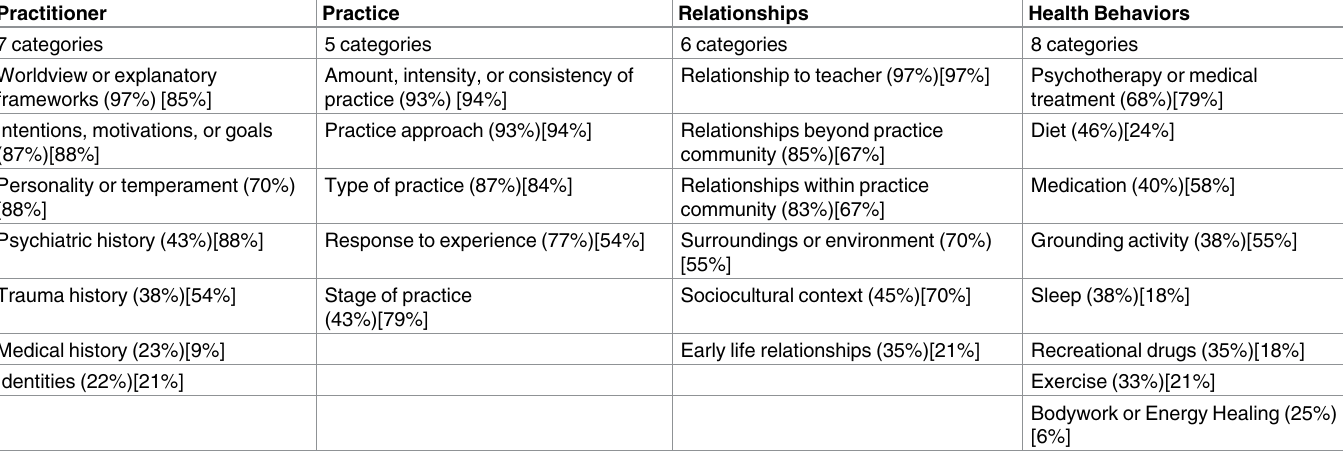
Table 6. Influencing factors coding